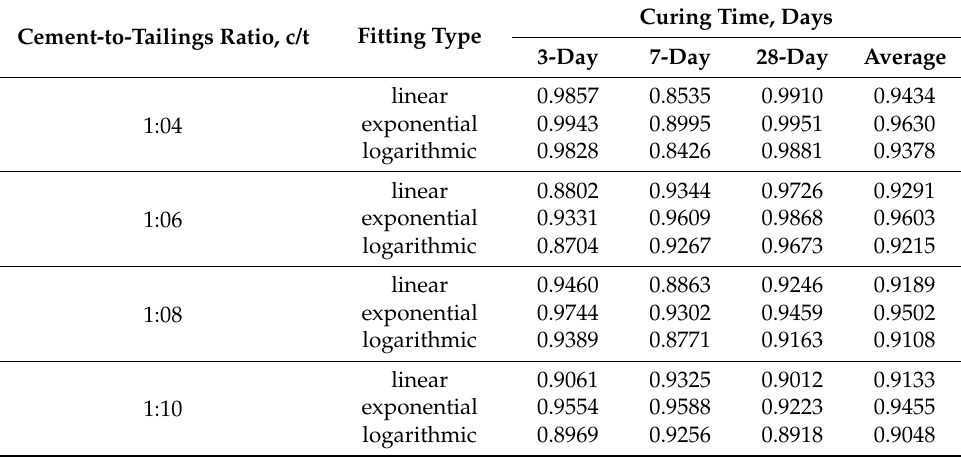
Table 8. UCS results of CTB samples under various solid